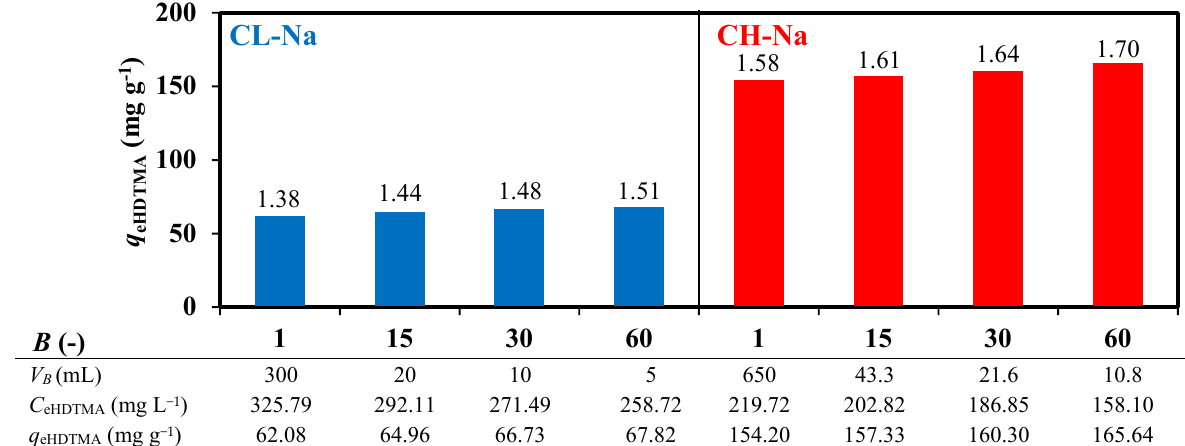
Figure 3. Impact of surfactant solution batching ( B ) on efficiency of zeolite modification in sealing circulation unit. DC values over the bars, Q = 4 mL min − 1 , C 0 HDTMA = 1050 mg L − 1 , T = 40 °C, x = 2.0 ECEC.